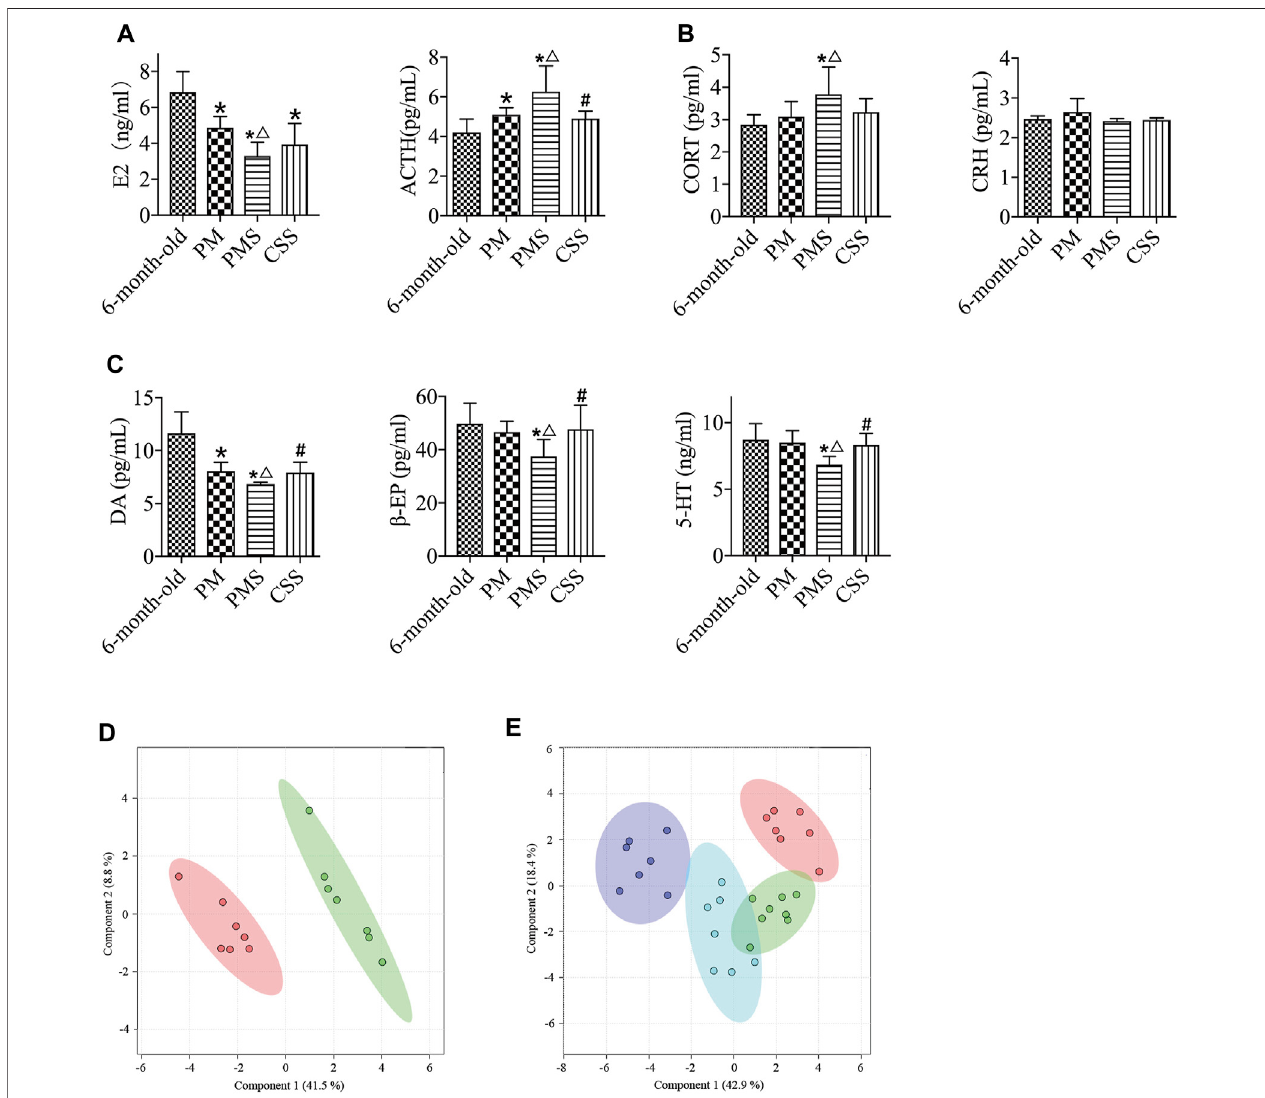
FIGURE6| PMSratstreatedwithCSS. (A) TheE2levelofthePMSratswithtreatmentwasnotsigni fi cantlydifferent. (B) ComparedwiththePMSrats,thelevelsof ACTH were reduced after treatment with CSS. (C) . The levels of β -EP, 5-HT, and DA inPMS rats wereenhanced after the treatment with CSS. (D) Metabolomic pro fi les of PMS rats with (red) and without (green) the CSS treatment. (E) PLS-DA analysis of the metabolomics of plasma from that CSS-treated PMS (blue), PMS (purple), perimenopausal (green), and 6-month-old (red) rats. “ * ” indicates the comparison with 6-month-old rats [ p < 0.05 (*)]; “ △ ” indicates the comparison with perimenopausal rats [ p < 0.05 ( △ )]; “ # ” indicates the comparison with untreated PMS rats [ p < 0.05 (#)].